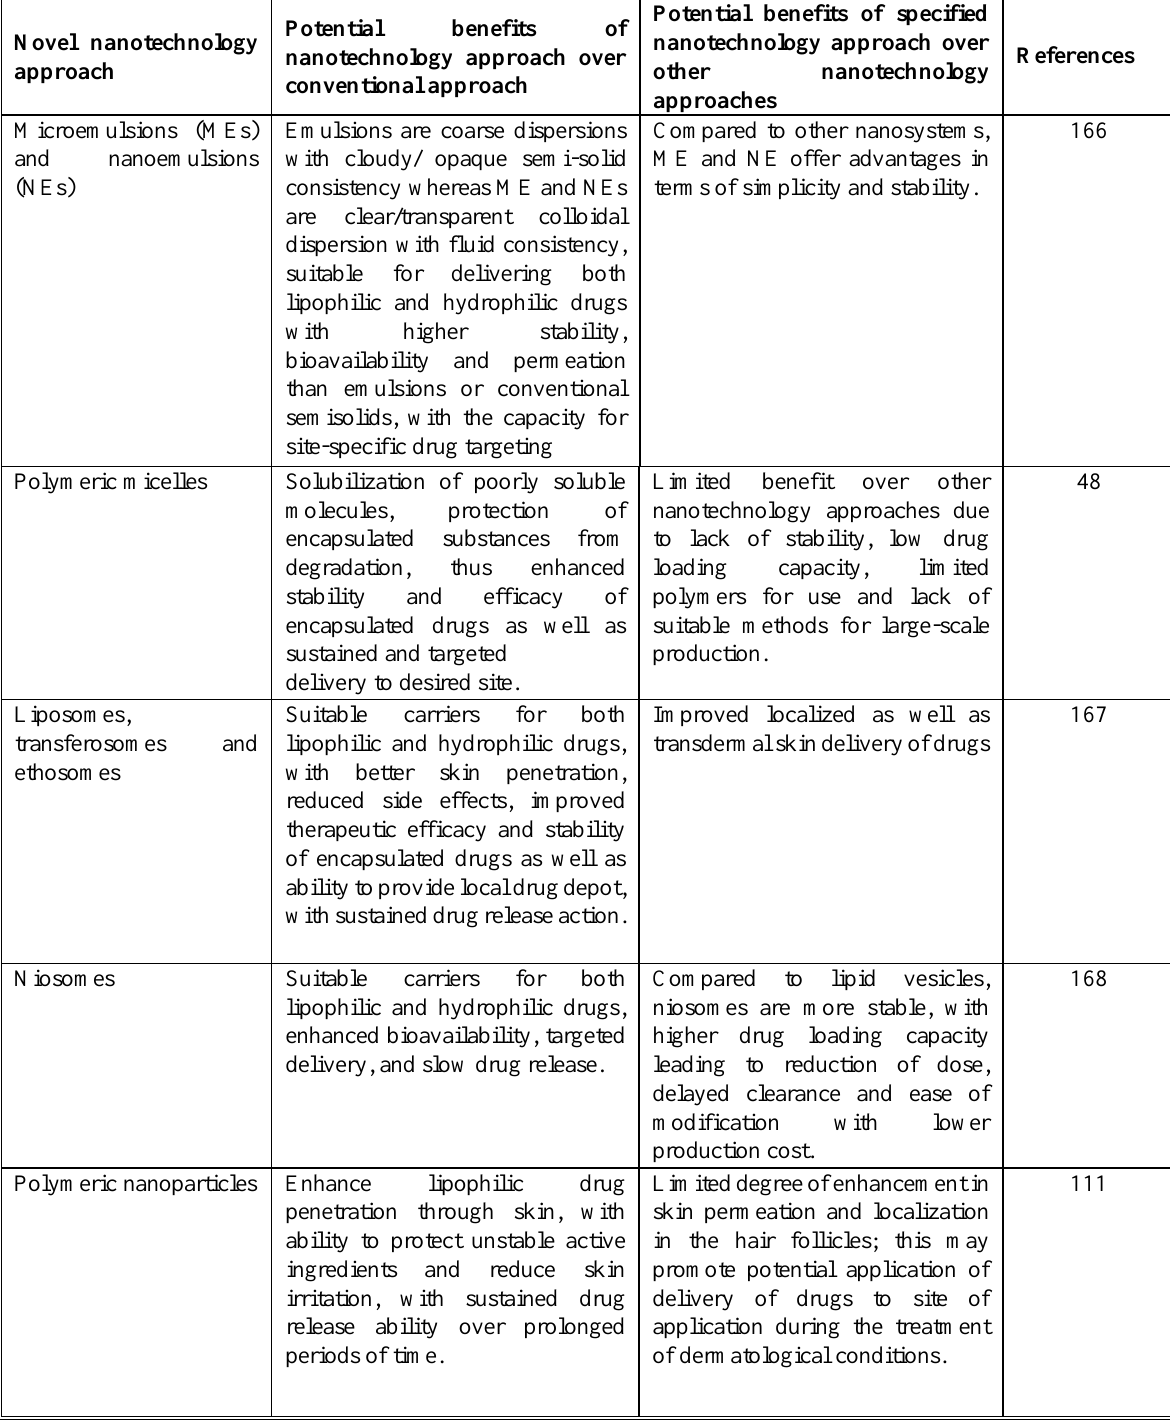
Table 3. Potential benefits of novel nanotechnology approaches over the conventional dosage forms and potential advantages of nanotechnology approach compared to the other nanotechnology